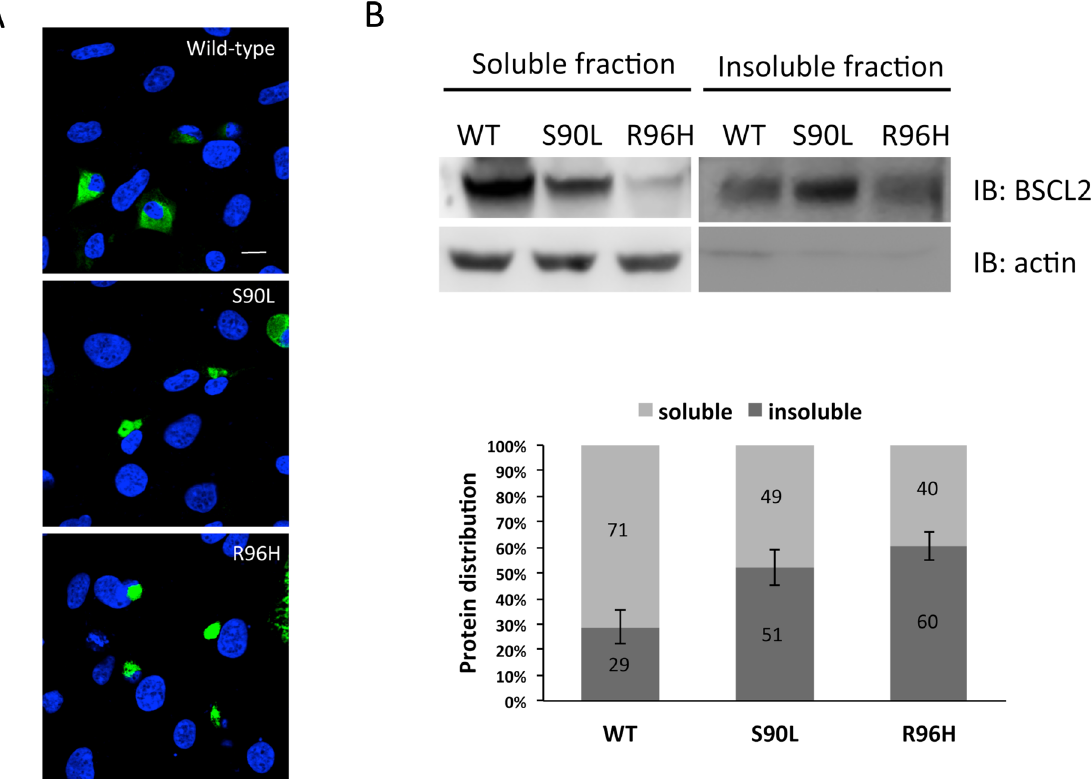
Fig 3. In vitro characterization of wild-type (WT) and mutant seipin proteins in HEK293 cells. (A) Representative images of immunofluorescence analyses of HEK293 cells transiently expressing WT, S90L, or R96H seipin labeled with anti-BSCL2 antibody (green) for staining seipin and 4 ’ -6-diamidino- 2-phenylindole (DAPI; blue) for nuclear counter stain. The images indicate that WT seipin was mainly expressed in the cytoplasm with a reticular staining pattern, whereas S90L or R96H mutants appeared to form large perinuclear aggregates. The experiments were repeated for three times and all had similar findings. (B) Images of representative immunoblots of the soluble and insoluble fractions from HEK293 cells transiently expressing WT, S90L, or R96H seipin. The levels of seipin in each fraction were measured by Western blot using the anti-BSCL2 antibody. The proportion of soluble and insoluble parts of each sample calculated by densitometric analyses is shown below. The error bars indicate SEM from 3 independent experiments. IB, immunoblotting.